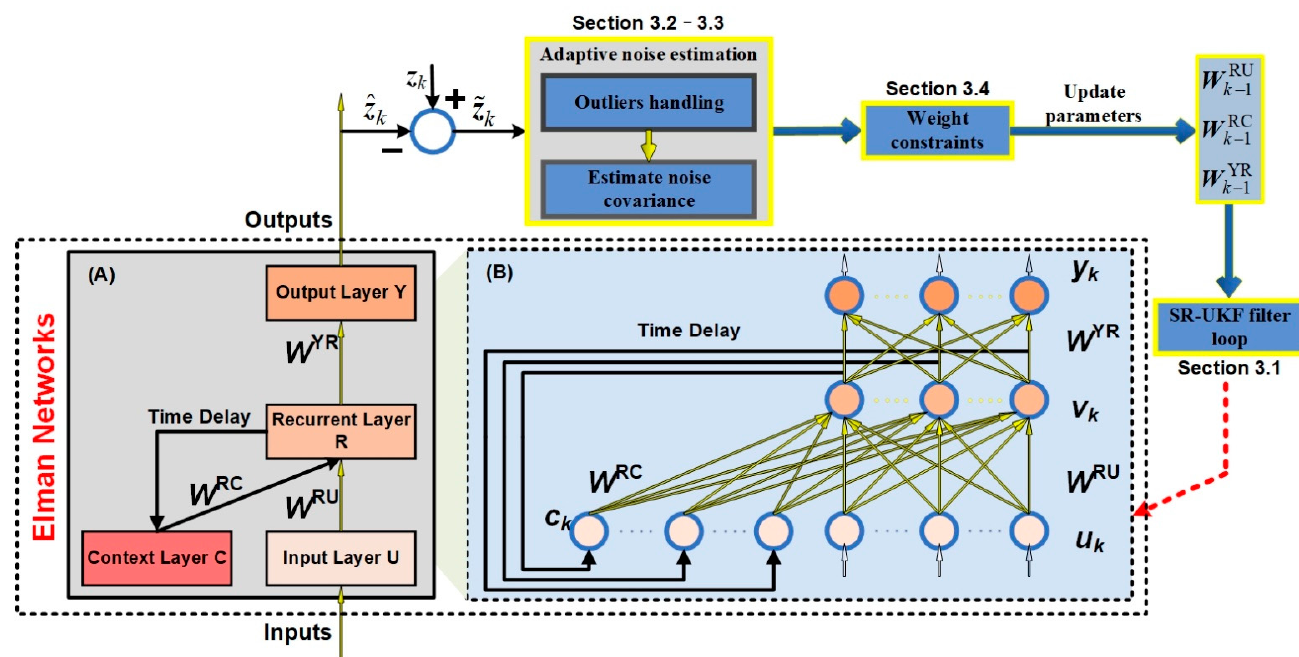
Figure 1. Schematic diagram of the proposed Elman-SR-UKF method. Figure 1. ( A ) The simplified topology of the Elman neural network; ( B ) A detailed expansion of module A. The Elman network mainly consists of four layers: the input layer U, the hidden layer (or recurrent layer) R, the context layer C and the output layer Y. W RU , W RC , and W YR represent the connection weight matrix from the input layer to the hidden layer, the context layer to the hidden layer and the hidden layer to the output layer, respectively. The output of the hidden layer after unit delay is used as the input of the next context layer, c k = v k − 1 , and it is applied to the hidden layer through the matrix W RC